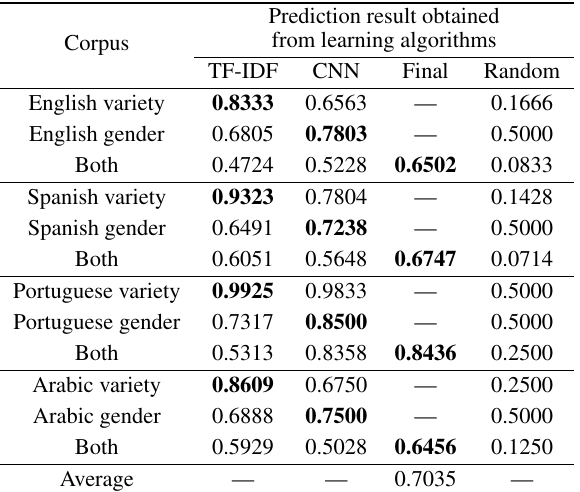
Table 16 10-fold cross validation on the four training collections [48]